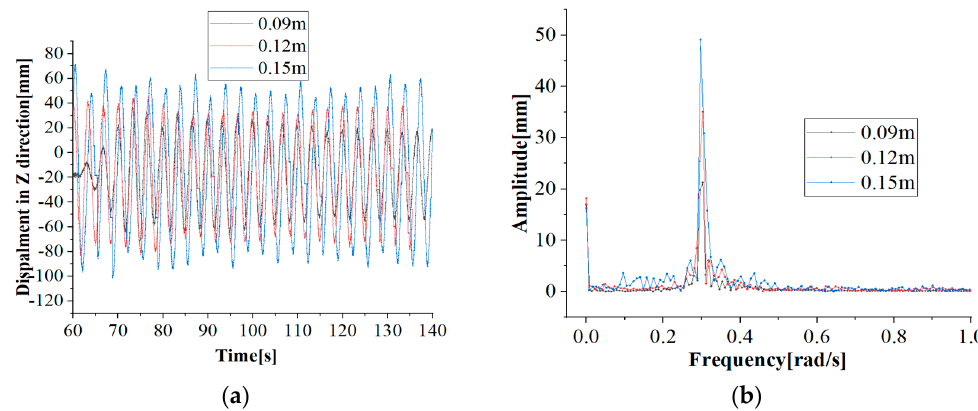
Figure 20. Heave response of the pedestal with different wave heights at 0.25 Hz. ( a ) Heave; ( b ) heave frequency domain curve.